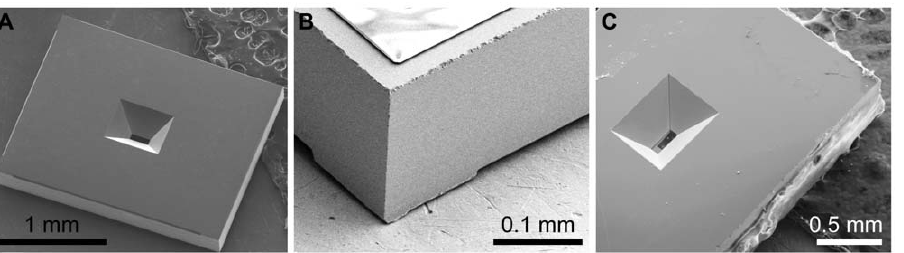
Figure 2. Scanning electron microscopy (SEM) images of the silicon microchips. The SEM images were recorded at 10 kV (S4700 Hitachi). (A) Image of the backside of a microchip showing the opening for the silicon nitride window. (B) Close-up of the diced edge of the microchip. The SU8 spacer layer is visible at the top (the layer charges under the influence of electron beam irradiation). (C) Image of a liquid enclosure assembled from two microchips and closed at all sides with epoxy. The bottom microchip is visible through the silicon nitride window confirming the alignment of the top- and the bottom window.